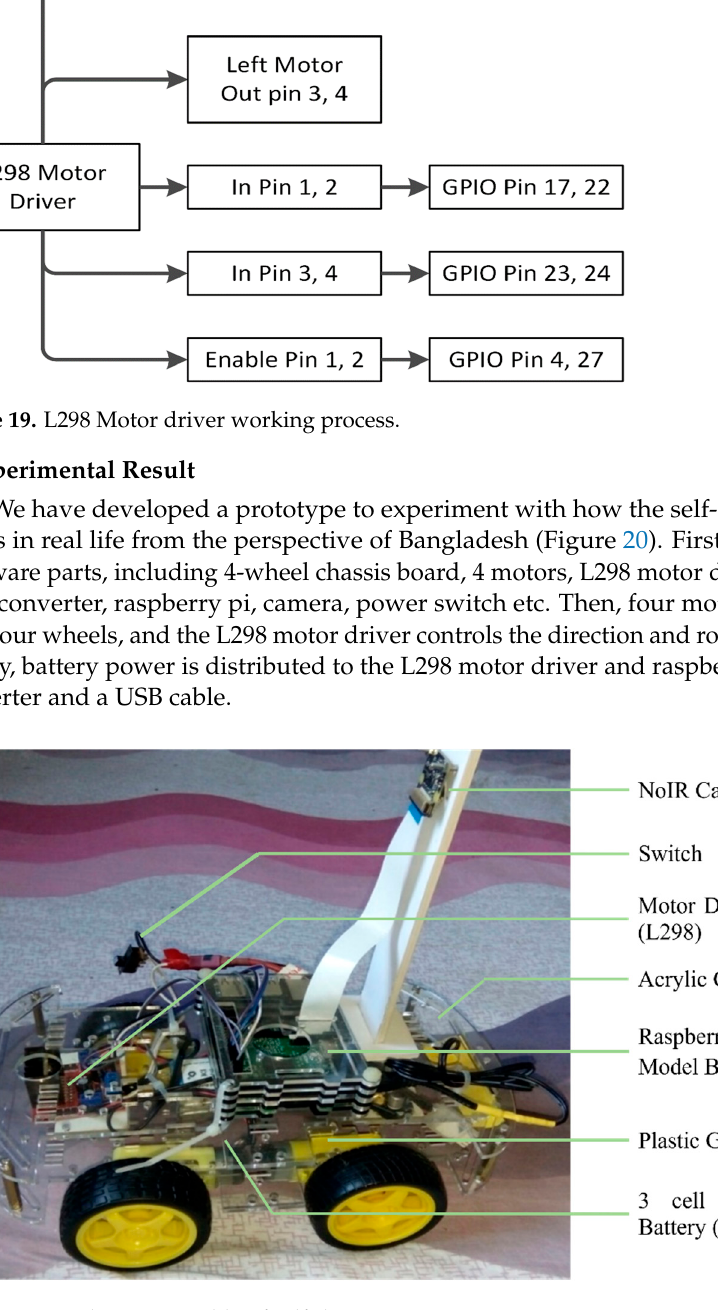
Figure 20. Hardware assembly of self-driving car.